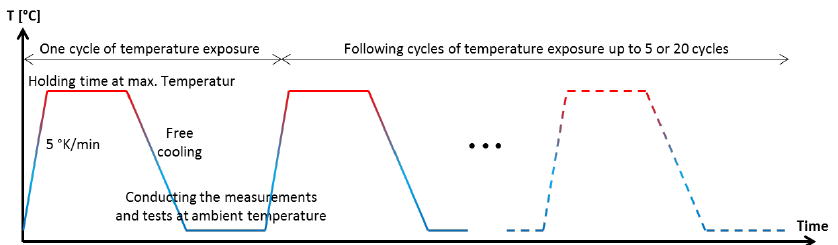
Figure 1. Sketch of the heating program, each complete cycle having a duration of 24 h.